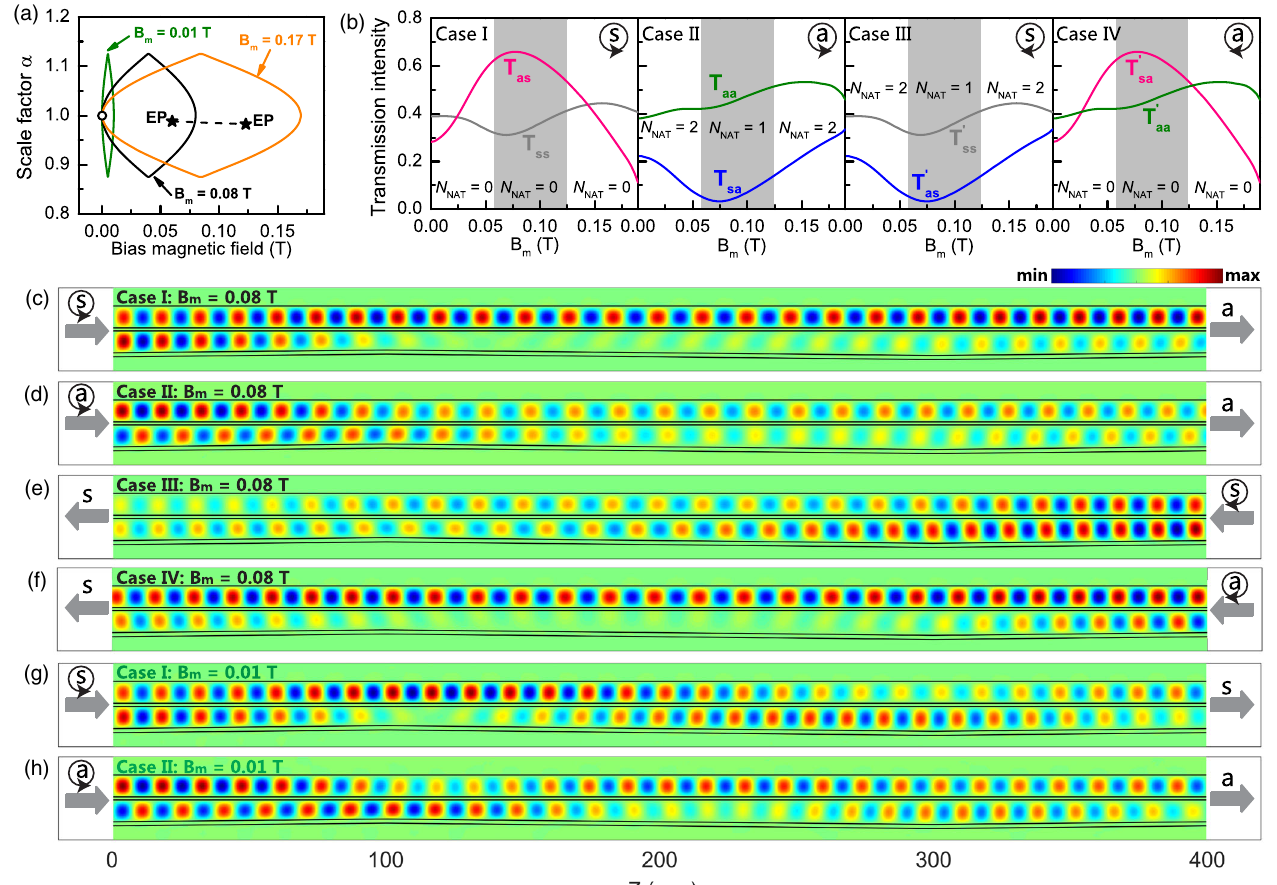
¼ 0 . 01 T (green loop not enclosing any EP), 0.08 T (black FIG. 3. (a) Three loops in parameter space, generated as examples with B m loop enclosing one EP), and 0.17 T (yellow loop enclosing two EPs). The starting/end point lies at B 0 ¼ 0 and α ¼ 1 , corresponding to the symmetric phase. The black dashed line represents the broken phase line, where the real parts of the eigenvalues coalesce. (b) Calculated transmission intensities for the four cases (see text for definition) as a function of B . The shaded region represents the m field strengths where one EP is dynamically encircled, and a state flip occurs for cases I and IVonly. Outside the shaded region, zero (left region) or two EPs (right region) are encircled. The number of nonadiabatic transitions (NATs) in the dynamical process, denoted by N , is given in different regions. (c) – (h) Numerically simulated H field distributions in the waveguide system with different input y NAT ¼ 0 . 08 T for cases I – IV are shown in (c) – (f), respectively, corresponding to an modes and injection directions. The results with B m ¼ 0 . 01 T, corresponding to an encircling of encircling of one EP. Panels (g) and (h) show results for cases I and II, respectively, with B m zero EP. In all of the simulations, the frequency is 9 GHz, and the system parameters are the same as those given in Fig.